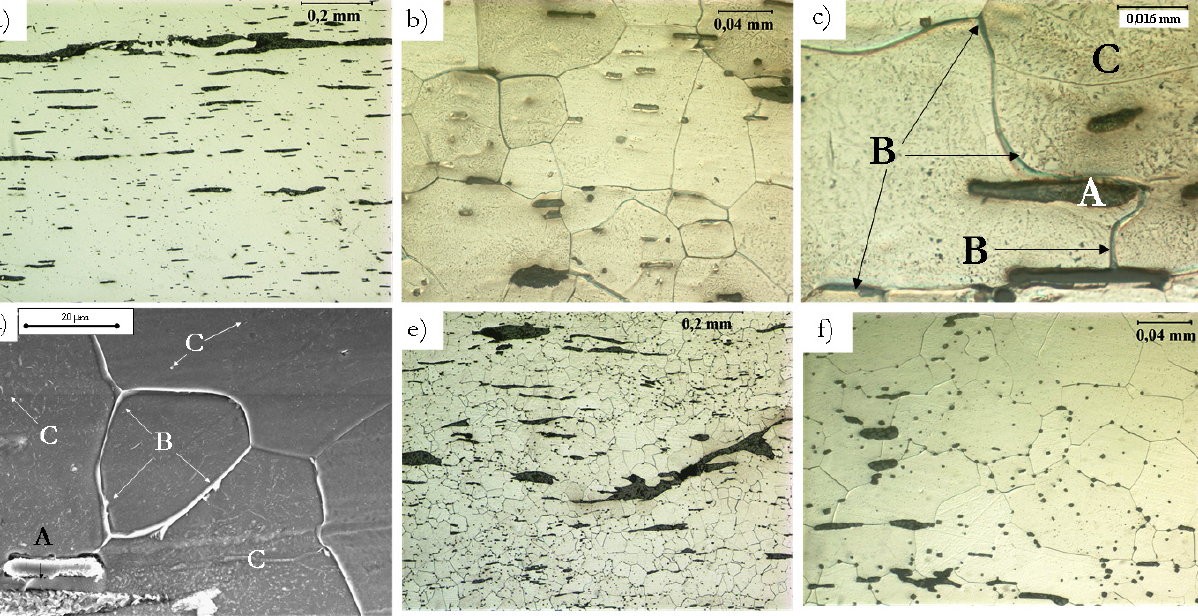
Figure 3: Microstructure of investigated puddled steel (1899-1904) – marked as B and W -steel, in (a) post-operating state (light microscopy) – presented nonmetallic inclusions typical for puddled steel, (b) post-operating state; ferrite grains with numbers of nonmetal inclusions, (c) magnified ferrite grains structure with nonmetallic inclusions – mainly silicates (A) and thick envelope of Fe 3 C III on the grain boundary (B) with numbers of degradation separations brittle phase inside ferrite grains (C), post-operating